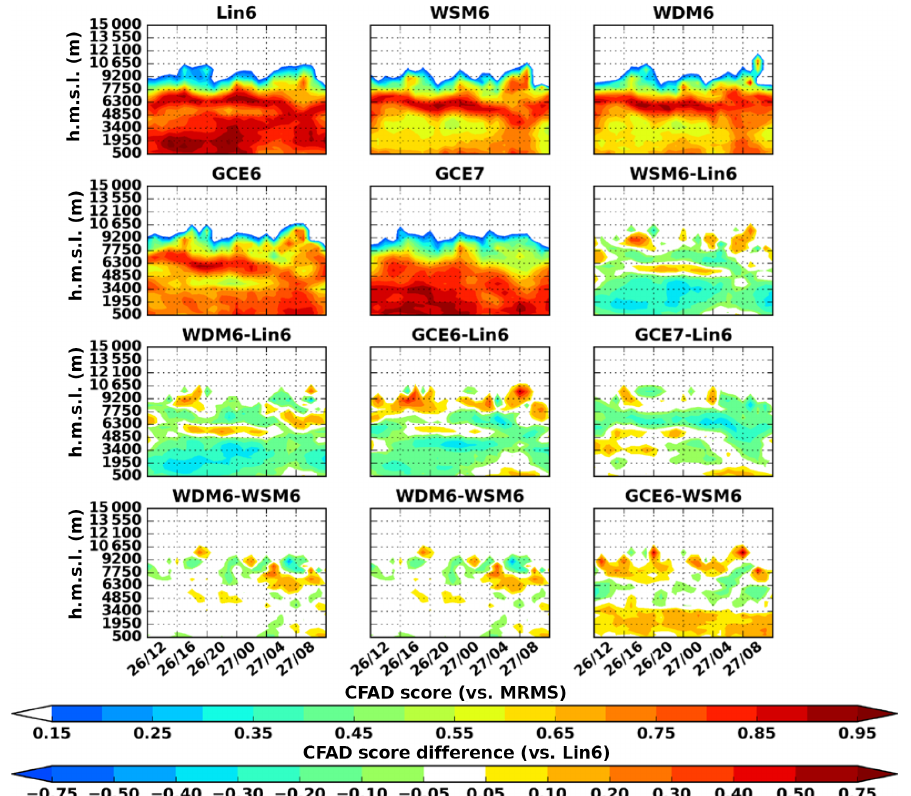
Figure 11. Domain 3 (5km grid spacing), hourly CFAD scores (See Eq. 2) of radar reflectivity and indicated differences from case 4 starting 12:00UTC, 26 January 2015 and ending on 12:00UTC, 27 January 2015. The time period corresponds to the same time period as in Fig. 5. The y axis shows height above mean sea level (h.m.s.l.;